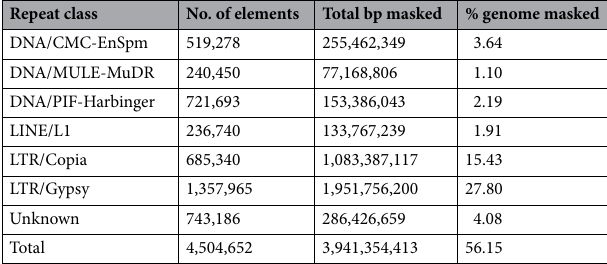
Table 1. Repeat sequence annotated in KK3 genome.